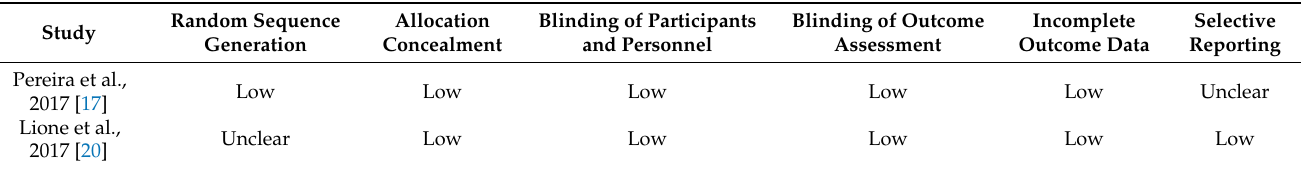
Table 4. Assessment of the risk of bias in RCTs.